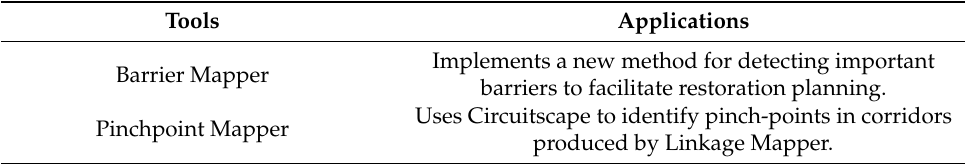
Table 6. Linkage Mapper Tools choice.